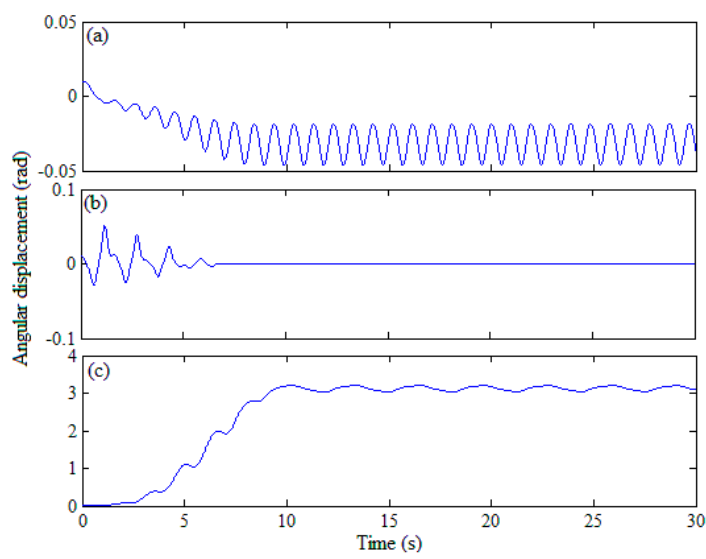
ω = 6.5, µ = 0.05; ( b ) ω = 12, µ = 0.05; and ( c ) ω = 40, µ = Figure 7. Numerical simulation: ( a ) ω = 6.5, μ = 0.05; ( b ) ω = 12, μ = 0.05; and ( c ) ω = 40, μ = 0.05. Figure 7. Numerical simulation: ( a )